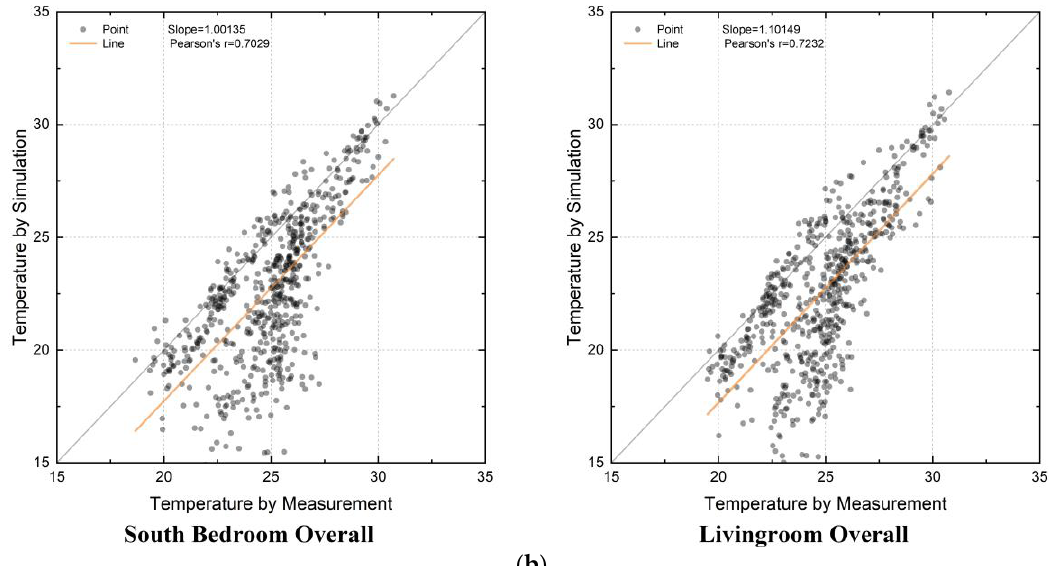
Figure 14. Correlation between simulated results and measured results of the south bedroom and living room in Shenyang; drawn by the authors. ( a ) Correlation between 6 a.m., 12 a.m., 6 p.m., and 12 p.m. ( b ) Overall correlation.